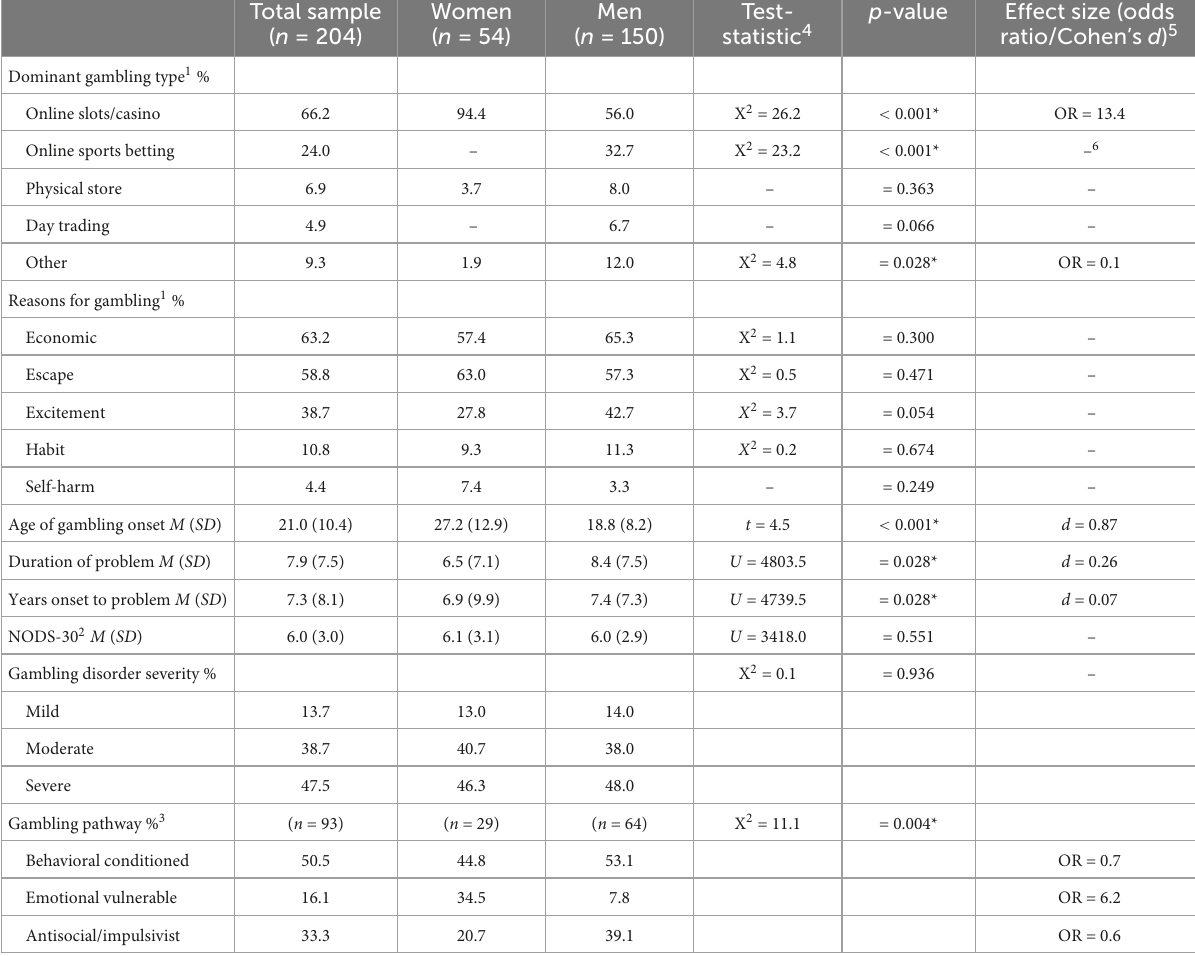
TABLE 2 Gambling behaviors and pathways for total sample, women, and